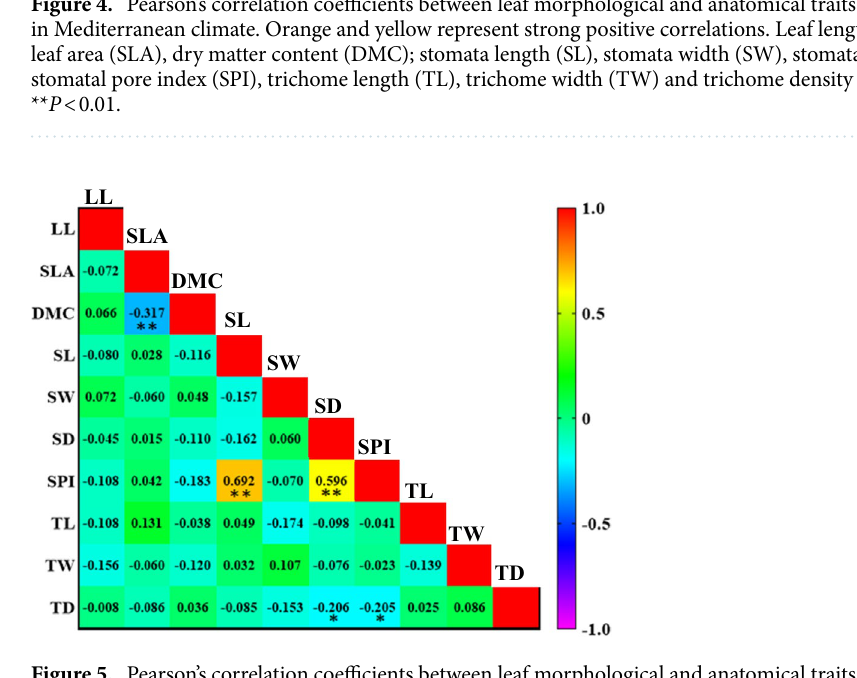
Figure 5. Pearson’s correlation coefficients between leaf morphological and anatomical traits of Quercus brantii in sub-humid climate. Orange and yellow represent strong positive correlations, and blue strong negative correlations. Leaf length, (LL), specific leaf area (SLA), dry matter content (DMC); stomata length (SL), stomata width (SW), stomatal density (SD), stomatal pore index (SPI), trichome length (TL), trichome width (TW) and trichome density (TD). * P < 0.05; ** P <